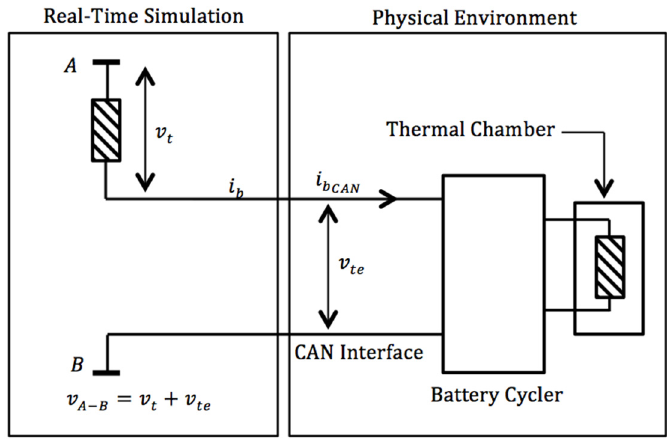
Figure 6. Experimental set-up for validation of the CILS